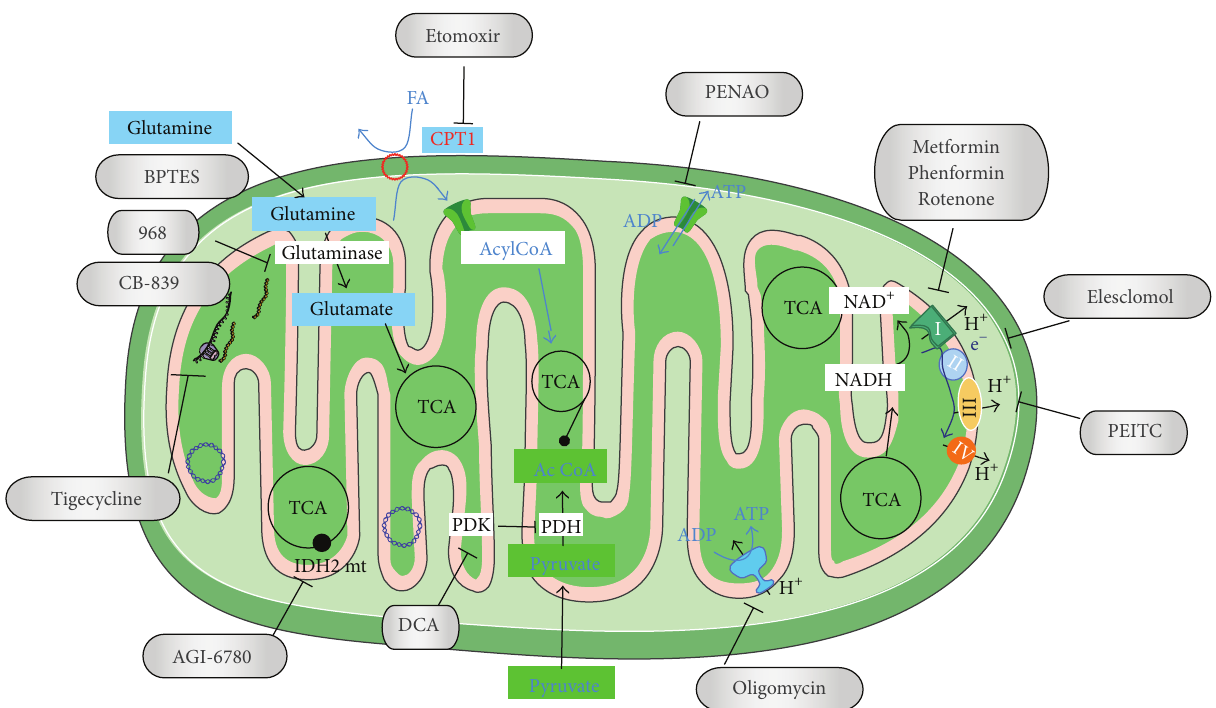
Figure 3: Diagram presenting the main potential mitochondrial targets for cancer treatment (see text for